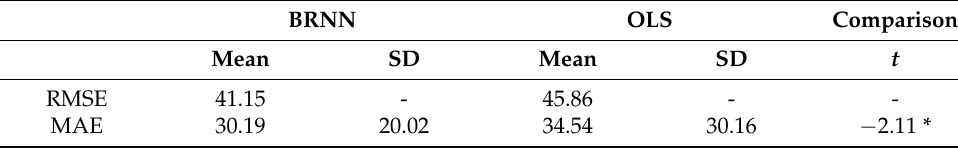
Table 4. Error Indicators (RMSE and MAE) between BRNN and OLS. BRNN OLS Comparison Mean SD Mean SD t RMSE 41.15 - 45.86 - - MAE 30.19 20.02 34.54 30.16 − 2.11 *